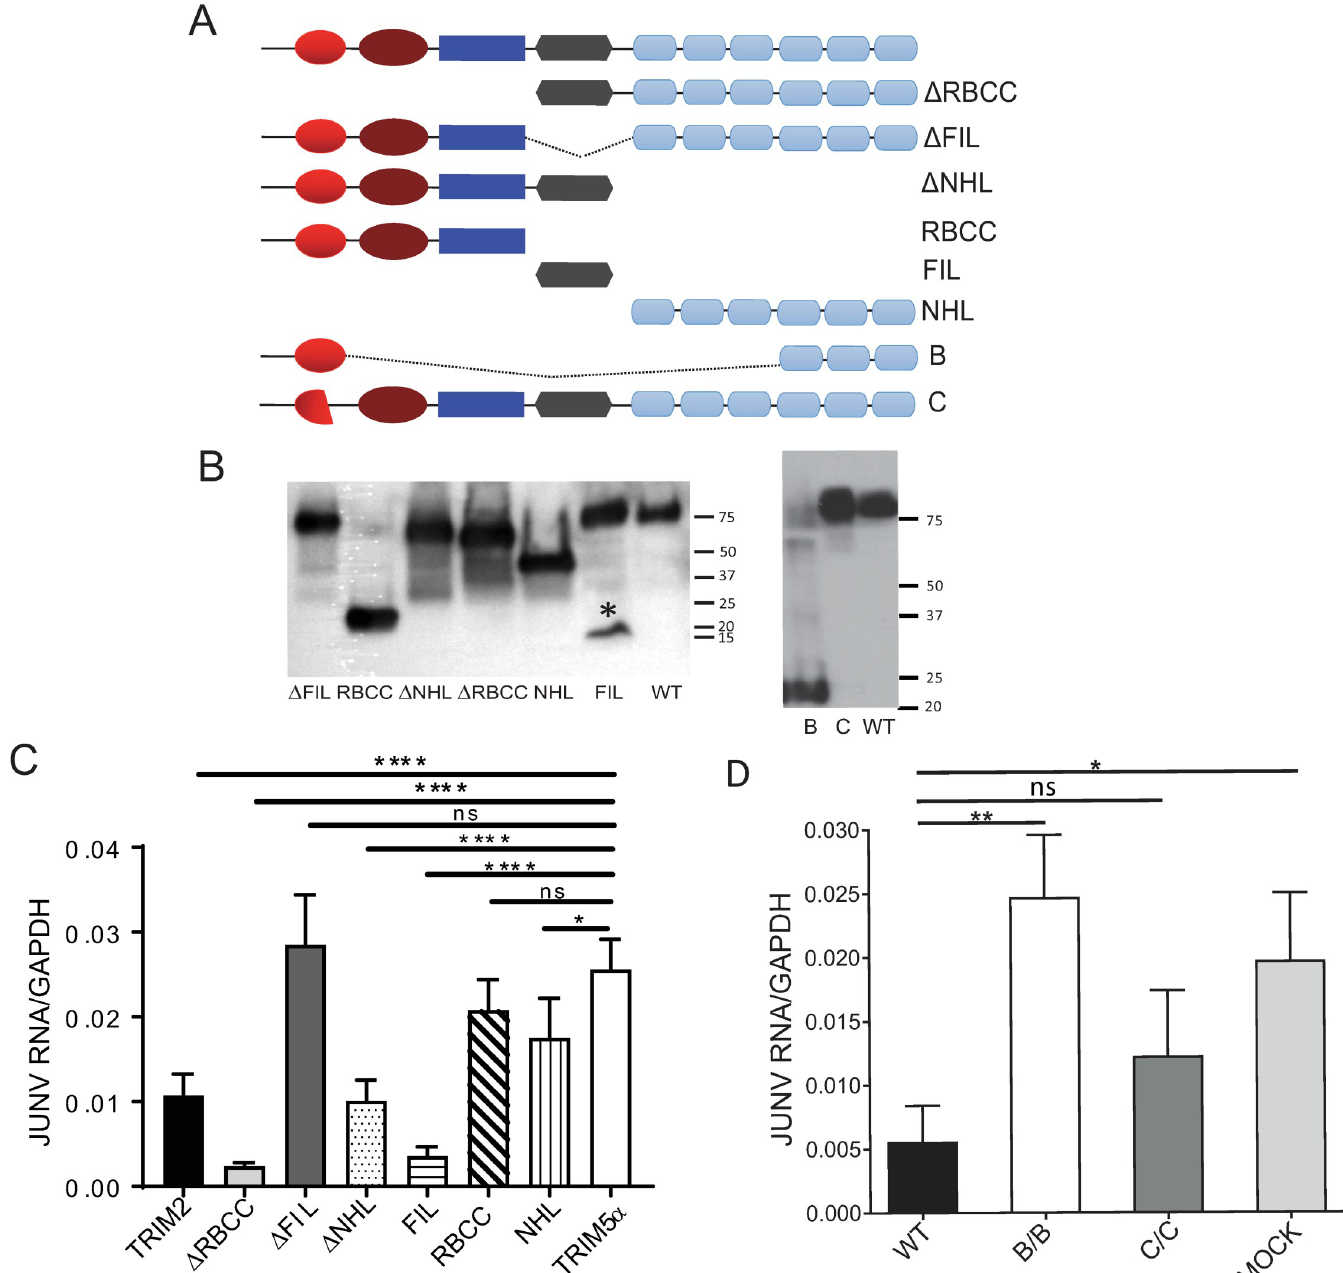
Fig 5. The TRIM2 FIL domain is required for antiviral activity. (A) Diagram of the different deletion constructs. The Δ RBCC, Δ NHL, and NHL constructs were previously described [25]. All constructs were c-myc-tagged. (B) Western blot showing expression of the different deletion constructs. � denotes the monomeric FIL domain. (C) TRIM2 and deletion constructs were transfected into U2OS cells for 24 hr and then infected with Candid 1 (MOI 1). RNA was isolated at 24 hpi and analyzed by RT-qPCR for viral RNA levels. Shown are the averages ± SD of 3 independent experiments. One-way ANOVA was used to determine significance. � P � 0.05; ��� P � 0.001; ���� P � 0.0001. (D) The same experiment was done with the B and C expression constructs. The average ± SD of 3 independent experiments are shown. One-way ANOVA was used to determine significance. �� P � 0.005. GAPDH, glyceraldehyde-3-phosphate dehydrogenase; hpi, hours post infection;